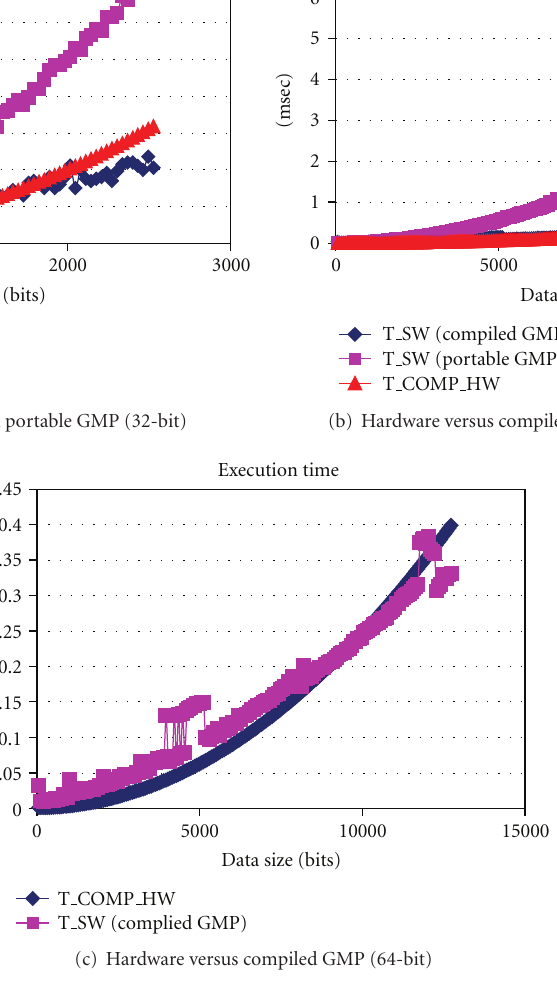
Figure 13: Multiplication execution